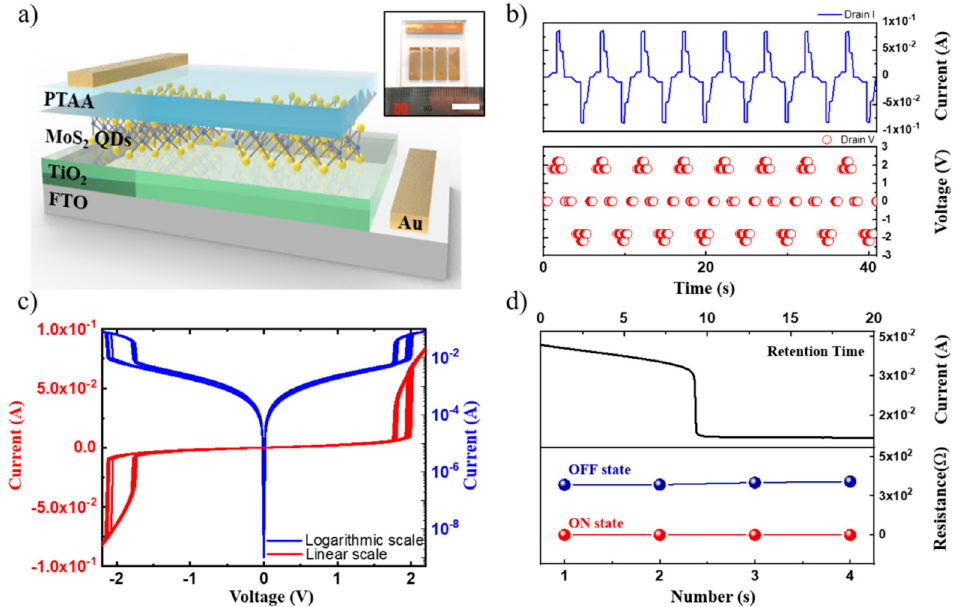
Figure 23. ( a ) Schematic illustration of a MoS 2 QD-based memristor (inset: photograph of the device; scale bar is 1 cm). ( b ) Current changes caused by various pulsed biases with a pulse duration of 40 ms. ( c ) Hysteresis loops in the I-V curves. ( d ) Retention time of states and ON/OFF ratio. Reproduced with permission from [68] with permission from Elsevier B.V., 2020.